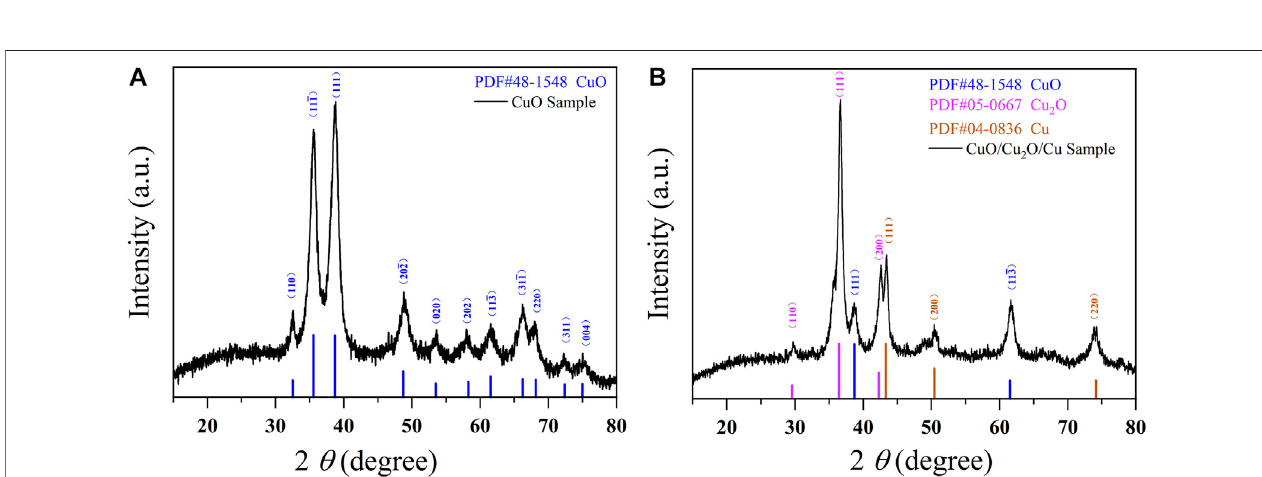
FIGURE 2 | The XRD patterns of CuO nanowires (A) and CuO/Cu 2 O/Cu nanocomposites (B) .